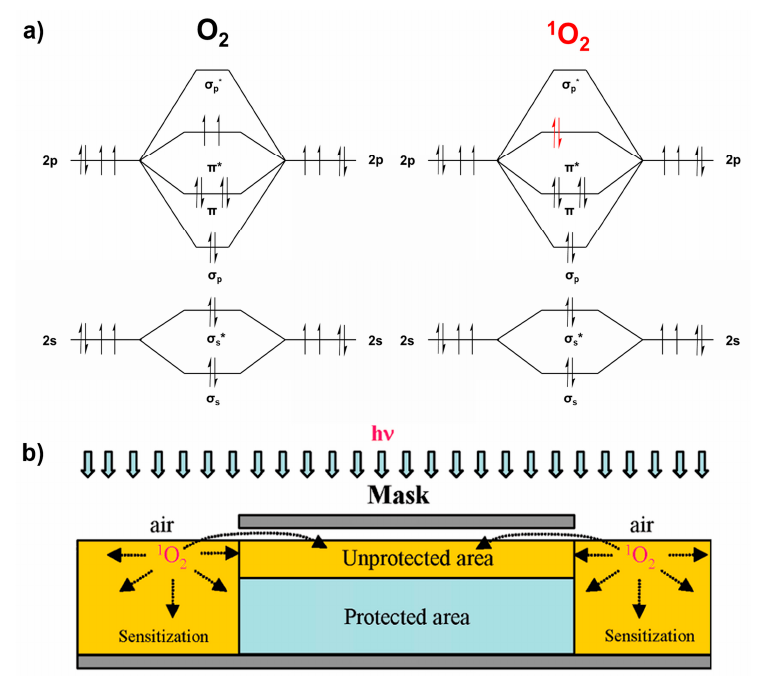
Figure 9. ( a ) Molecular orbitals of triplet and singlet oxygen. ( b ) Schematic representation of singlet oxygen-mediated photocatalytic lithography. The reactive species is generated in correspondence with the exposed regions but can travel outside the sensitizer layer into the masked area. Reproduced with permission from [68], American Chemical Society,